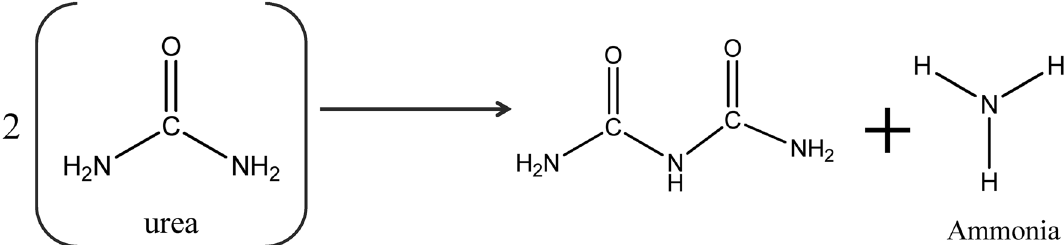
Figure 1. Possible mechanism of urea is converted to ammonia through